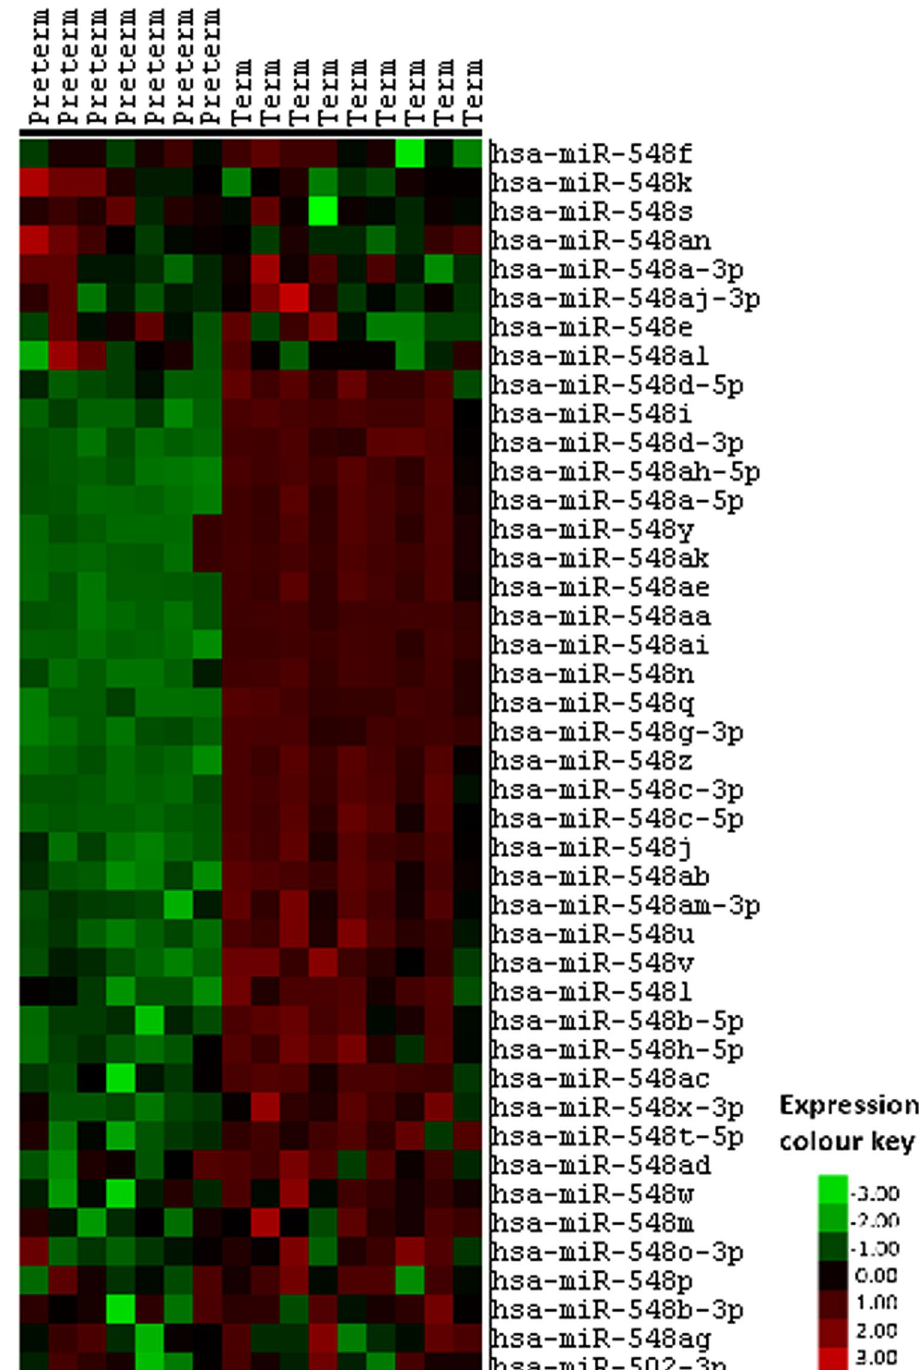
Figure 2. Heat map of endogenous miR548 family expression in maternal plasma at 20 weeks gestation. Heat map shows miR-548 family miRNA from human maternal plasma at 20 weeks gestation in women who went on to deliver at term (n = 9) or experience SPTB at 28–32 weeks (n = 7). Each column represents one plasma sample with red = upregulated, green = downregulated and black =